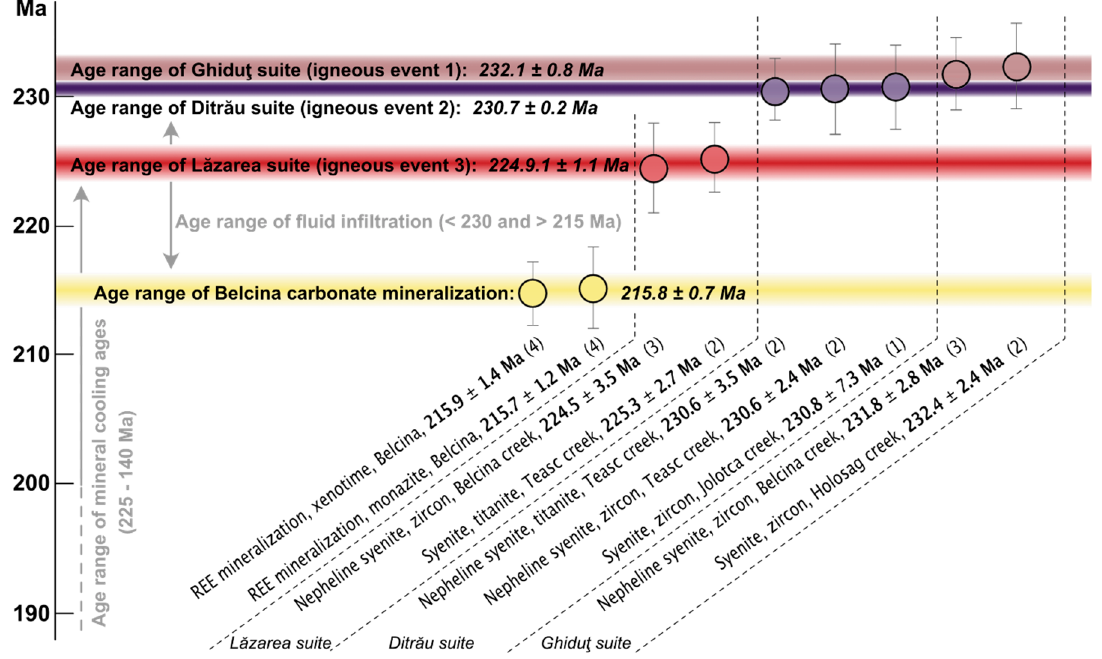
Figure 10. Compilation of inferred mean intrusion ages for the alkaline rocks of the DAM, the formation age of the Belcina carbonate mineralized veins, and the age ranges for metasomatic/hydrothermal overprinting and mineral cooling ages. Data are from (1) [31]; (2) [6]; (3) this work; (4) [56]. Color coding as in Figures 1 and 9.